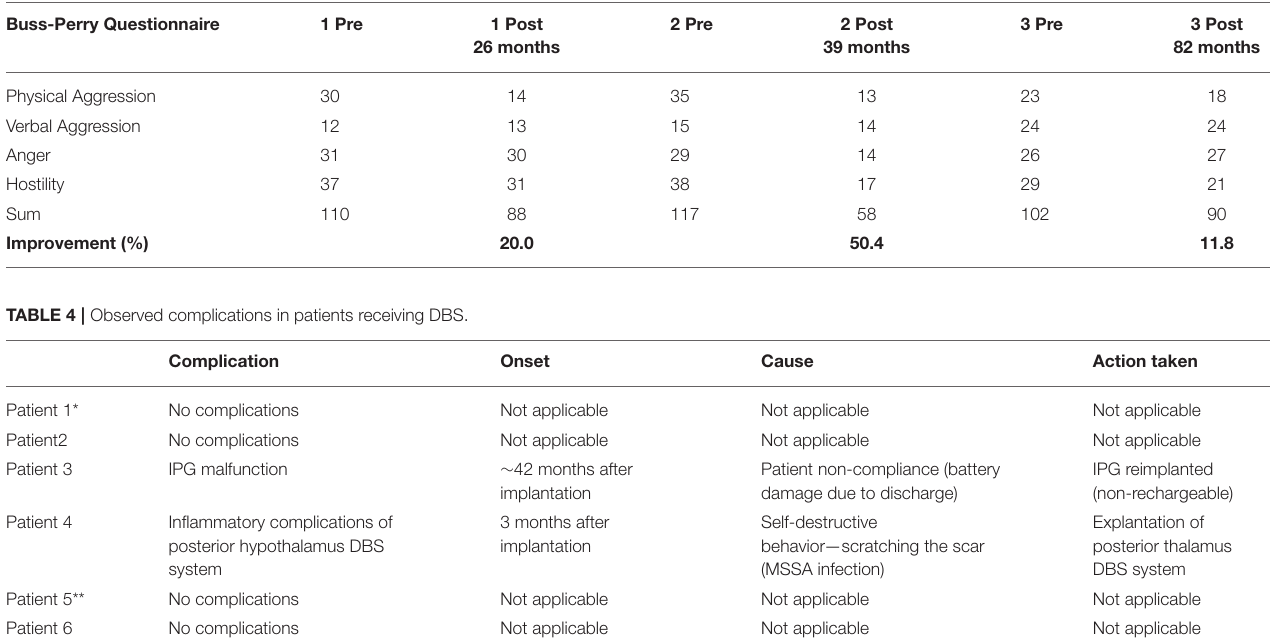
TABLE 3 | Buss-Perry Questionnaire (Amity version) results.